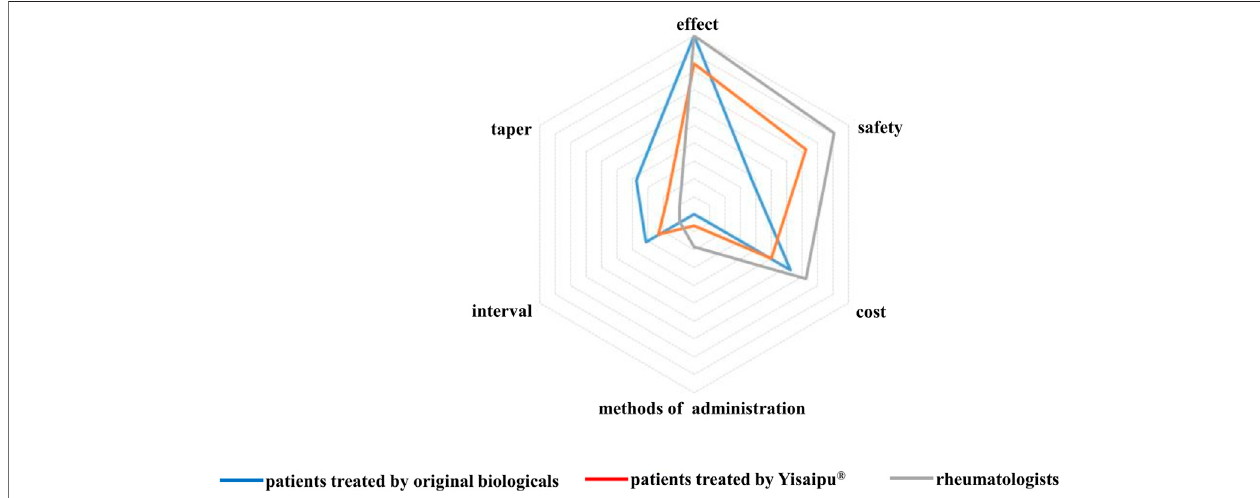
FIGURE 1 | Concerned problems in original biological and Yisaipu ® groups, The most concerned problems in original biological group were the therapeutic effect (41, 100%), cost (25, 61.0%), safety (15, 36.6%),drug tapering and discontinuation (15, 36.6%), interval ofdrug administration (13, 31.7%), routeofdrug administration (0, 0%). The most concerned problems in Yisaipu ® group werethe therapeutic effect (150, 84.3%), safety (129, 72.5%), cost (90, 50.6%),interval of drug administration (41, 23.0%), drug tapering and discontinuation (31, 17.4%), and route of drug administration (12, 6.7%). The most concerned issues of the rheumatologists were the therapeutic effect (11, 100%), safety (10, 90.9%), cost (8, 72.7%), way of injection (2, 18.2%), interval of drug administration (1, 9.1%), and drug tapering and discontinuation (1, 9.1%).